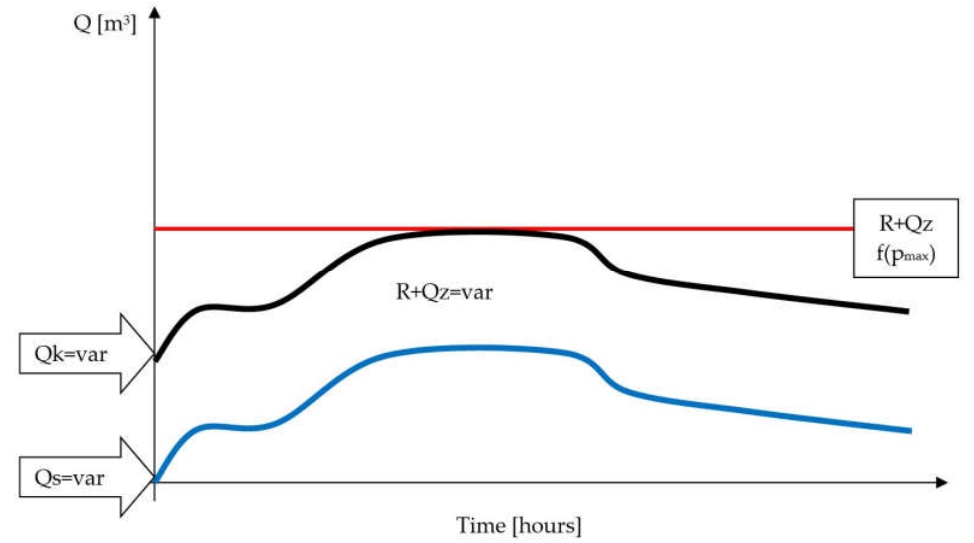
Figure 3. Graph of optimized operation process of piston compressor.